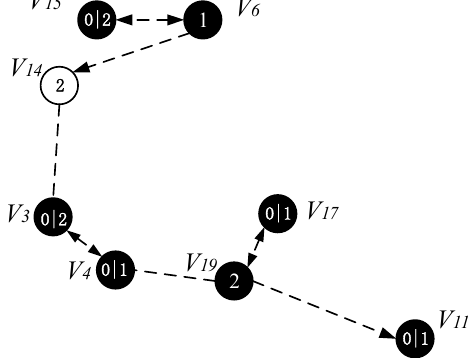
Figure 20. Broadcast backbone of AAS-LBR scheme.